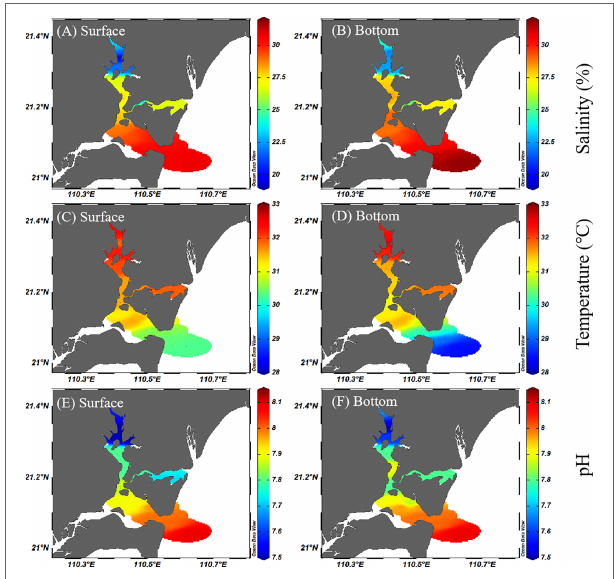
FIGURE 2 | Spatial distributions of salinity (A, B) , temperature (C, D) and pH (E, F) in the surface and bottom water of Zhanjiang Bay during the sampling